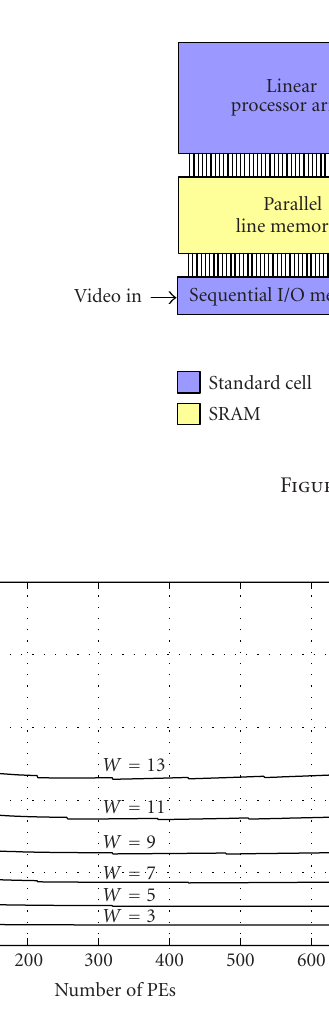
Figure 6: SIMD energy consumption for di ff erent filter